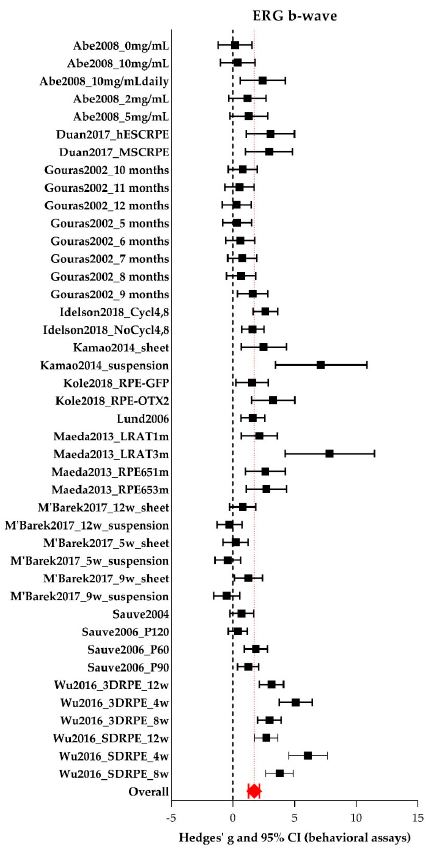
Figure 6. The meta-analysis on the effect of RPE transplantation on the ERG b-wave amplitude. For every experimental group, Hedges’ g (a measure for effect size using smaller sample sizes, black solid squares) and its 95% confidence interval (CI) are graphically shown. The left side of the dashed black line (Hedges’ g = 0) favors the control group (untreated or sham-operated) and the right side favors the experimental group (RPE transplantation). Overall, an RPE transplantation increased the b-wave amplitude significantly (Hedges’ g 1.734 (1.295–2.172), red diamond).